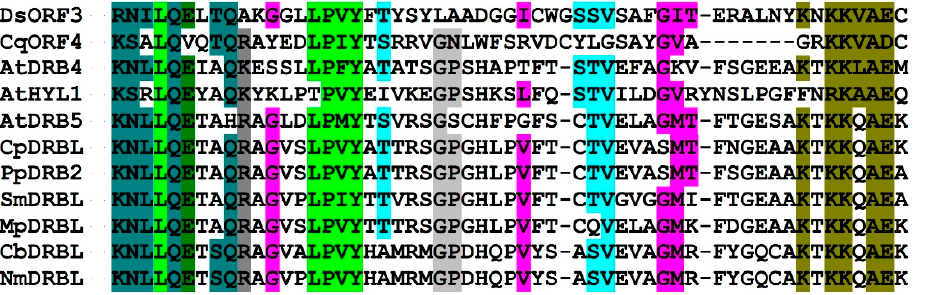
Figure 4. Multiple sequence alignment of the dsRNA-binding active centers of proteins HYL1, DRB4 and DRB5 from A. thaliana with vDRB proteins of D. scoparium (DsORF3) and C. quitensis (CqORF4) as well as DRB-like proteins of moss Ceratodon purpureus (CpDRBL—accession KAG0625911), moss Physcomi- trium patens (PpDRB2-XP_024393530), lycophyte Selaginella moellendorffii (SmDRBL-EFJ14280), liverwort Marchantia polymorpha (MpDRBL-PTQ26790), charophyte algae Chara braunii (CbDRBL-GGXX01036972), charophyte algae Nitella mirabilis (NmDRBL-JV799478), charophyte algae Spirogyra pratensis (SpDRBL- GFWN01008525). Motifs characteristic of domains of DSRM_AtDRB-like family are shown in color.